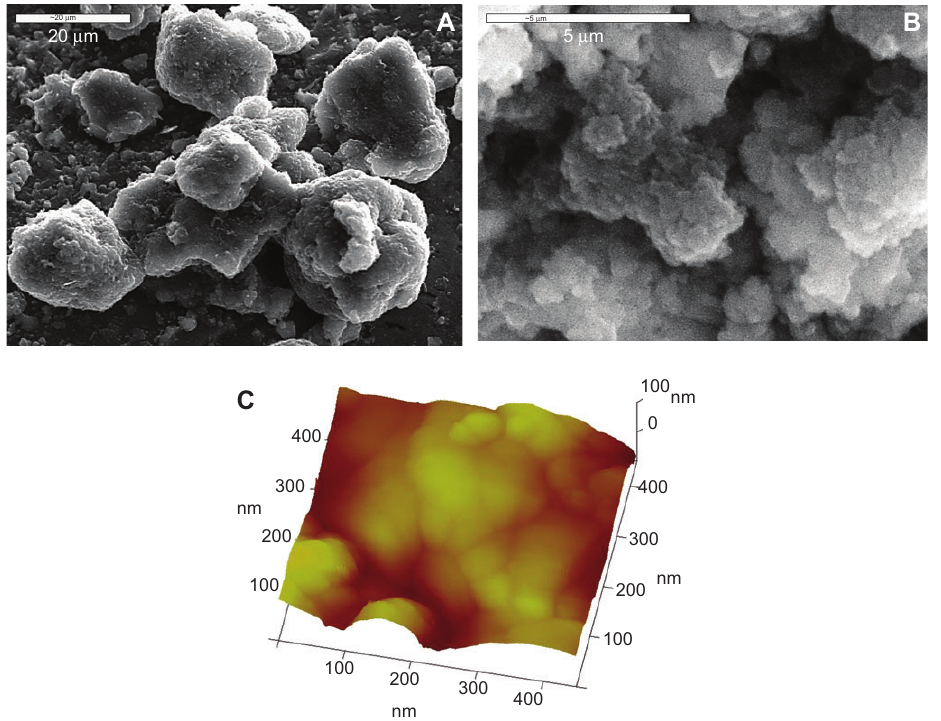
Figure 9 Morphology of a superhydrophobic surface revealed using SEM (A and B) and AFM (C). The hierarchical micrometer-sized structures shown in (A) consist of further nanostructures, as evidenced by the SEM (B) and AFM (C) images. The surface shown in the figure is a composite film that was prepared according to the procedures described in section